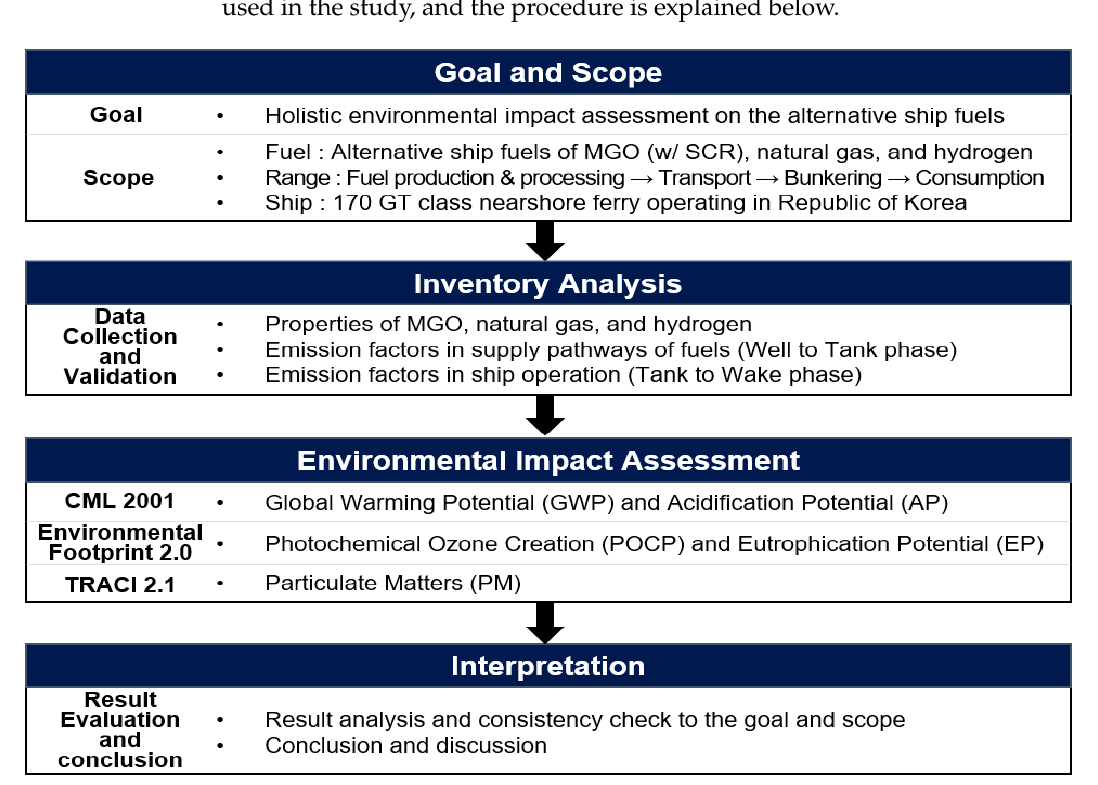
Figure 2. Framework of the life-cycle assessment for alternative fuels for ships.